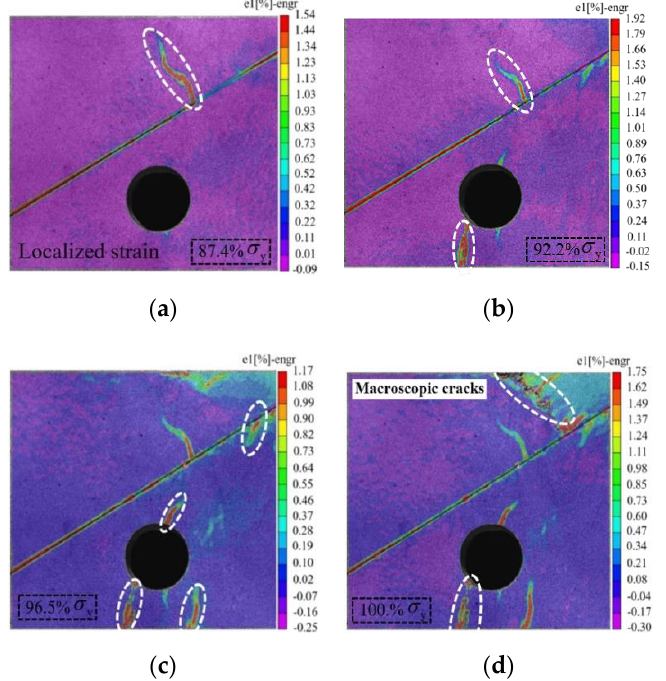
Figure 20. Evolution process of the major principal strain field of sample L -2. ( a ) 87.4% σ y ; ( b ) 92.2% σ y ; ( c ) 96.5% σ y ; ( d ) 100% σ y .